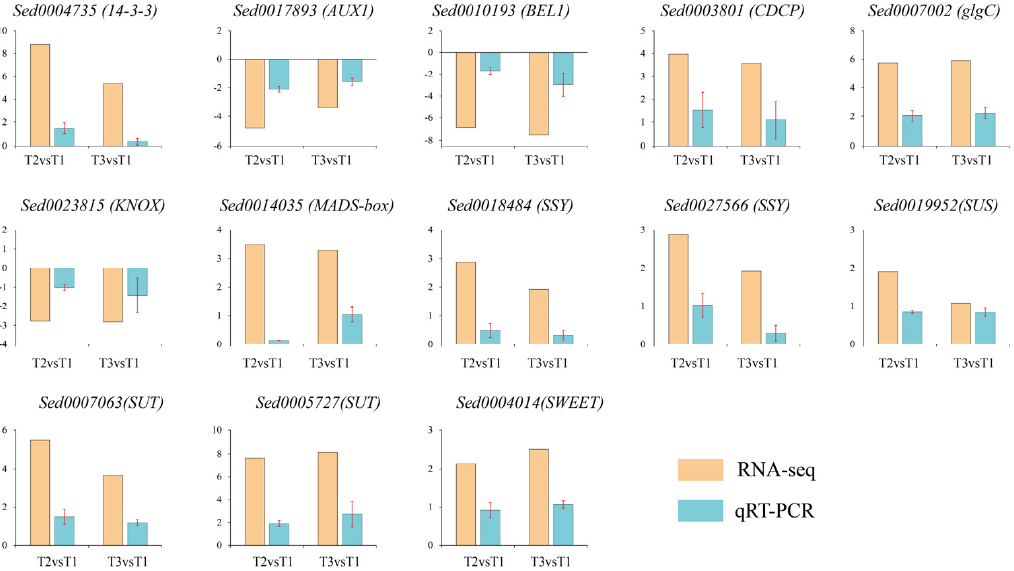
Figure 10. qRT-PCR verification of DEGs, where yellow bars represent RNA-seq data (log 2 FoldChange) and blue bars represent qRT-PCR data (log 10 2 −ΔΔ CT ).